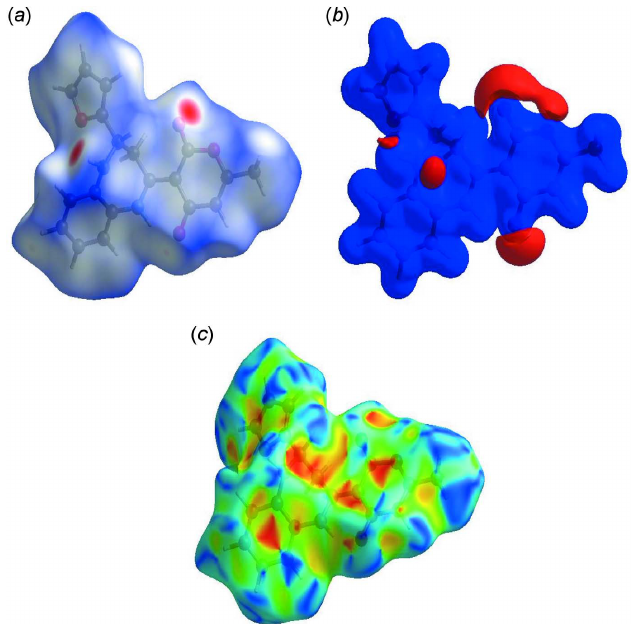
Figure 5 The full two-dimensional fingerprint plots for the title compound, showing ( a ) all interactions, and delineated into ( b ) H (cid:3)(cid:3)(cid:3) H, ( c ) H (cid:3)(cid:3)(cid:3) O/ O (cid:3)(cid:3)(cid:3) H, ( d ) H (cid:3)(cid:3)(cid:3) C/C (cid:3)(cid:3)(cid:3) H, ( e ) C (cid:3)(cid:3)(cid:3) C, ( f ) H (cid:3)(cid:3)(cid:3) N/N (cid:3)(cid:3)(cid:3) H, ( g ) C (cid:3)(cid:3)(cid:3) O/O (cid:3)(cid:3)(cid:3) C and ( h ) O (cid:3)(cid:3)(cid:3) O interactions. The d i and d e values are the closest internal and external distances (in A˚ ) from given points on the Hirshfeld surface.